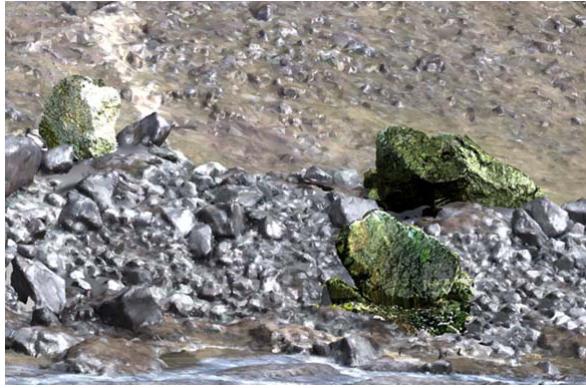
Figure 17: Modelled Boulders Combined with Raw Mesh from the TLS